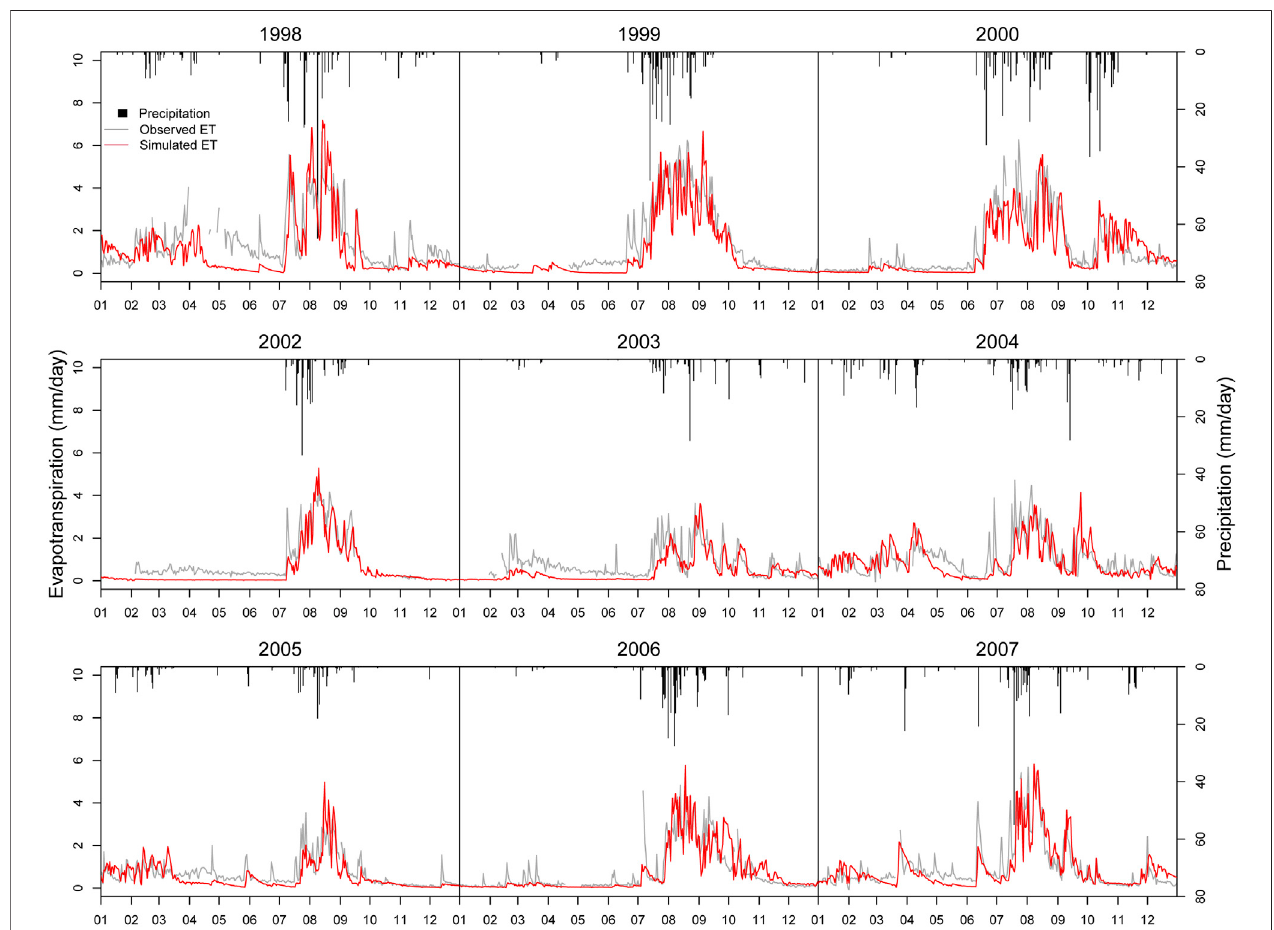
FIGURE 6 | Comparison of simulated and observed daily ET.